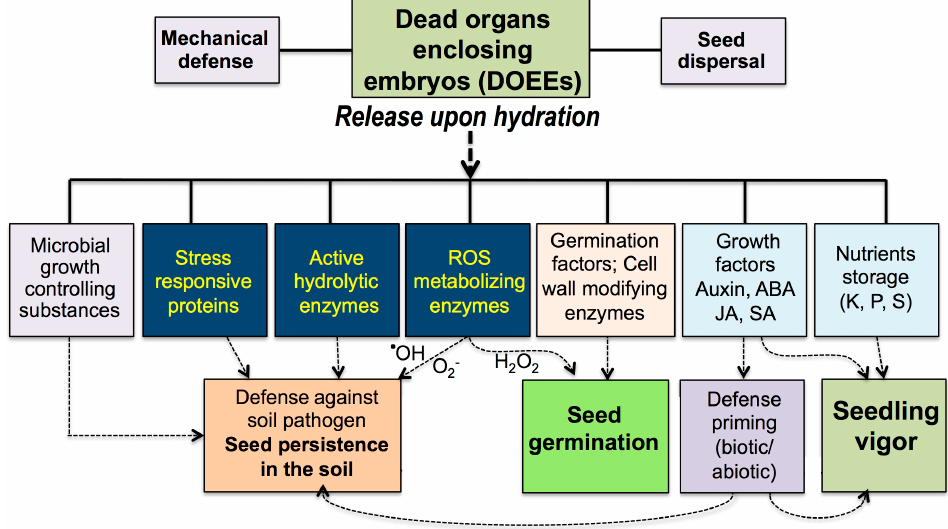
Figure 2. Dead organs enclosing embryos (DOEEs): More than a physical shield for embryo protection and means for seed dispersal, DOEEs function as a rich, long-term storage for multiple beneficial substances that are released upon hydration to the immediate surroundings of the dispersal unit (DU) including seeds, indehiscent dry fruits, florets and spikelets. These substances comprise active proteins (hydrolases, ROS metabolizing enzymes, etc.), metabolites (e.g., phytohormones) and nutrients that are released from DOEEs (e.g., seed coat, pericarp, and glumes) and have the potential to facilitate germination, confer defense against soil pathogen, trigger defense priming in germinating seeds toward biotic and abiotic stresses and supply nutrients and growth factors that contribute to seedling establishment and vigor.